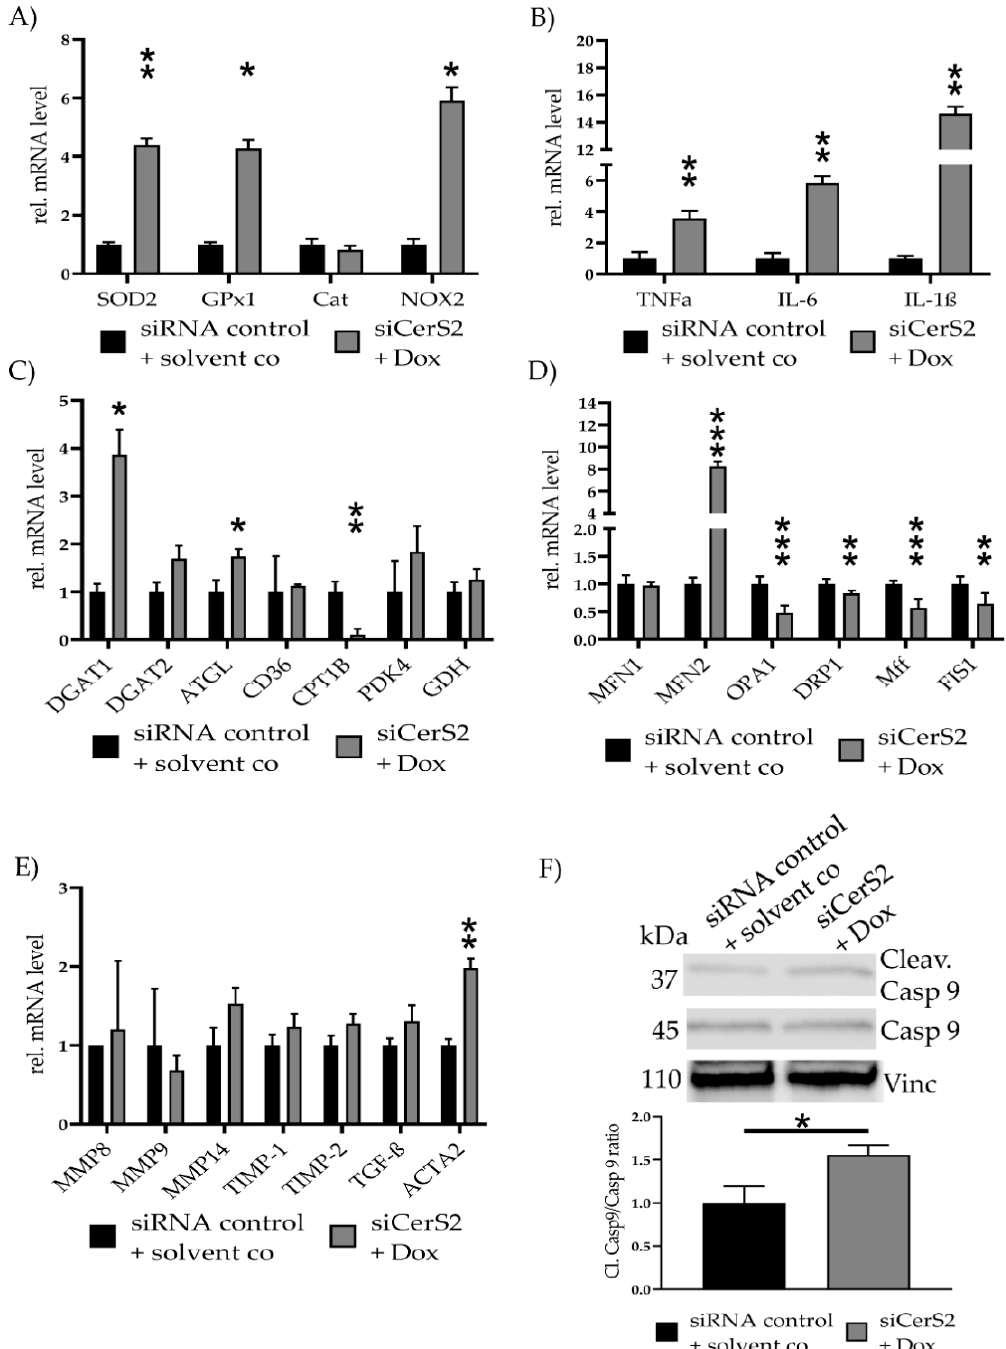
Figure 6. siCerS2 + Dox—Various effects of CerS2 kd determined with qPCR. hFSF were transfected with siRNA control or siCerS2 followed by 24 h incubation of solvent co or Dox. mRNA expressions were assessed with qPCR. ( A ) ROS scavenger ( SOD2, GPx1, Cat ) and inducer ( NOX2 ) expression. ( B ) Inflammatory cytokine expression of TNF α , IL-6 , and IL-1 β . ( C ) Metabolism associated gene expression of fatty acid metabolism ( DGAT1, DGAT2, ATGL, CD36, CPT1B ), pyruvate metabolism ( PDK4 ), and glutamate metabolism ( GDH ). ( D ) Mitochondria fusion ( MFN1, MFN2, OPA1 ) and fission ( DRP1, Mff, FIS1 ) related mRNA expression. ( E ) Fibrosis associated mRNA expression. ( F ) Cleav.Casp9/Casp9 ratio was detected with WB. Shown is one representative blot. Depicted are mean values and standard deviation of minimum three biological replicates. Significances were calculated with a t -test. * = significant to siRNA control + solvent co (* p ≤ 0.05, ** p ≤ 0.01, *** p ≤